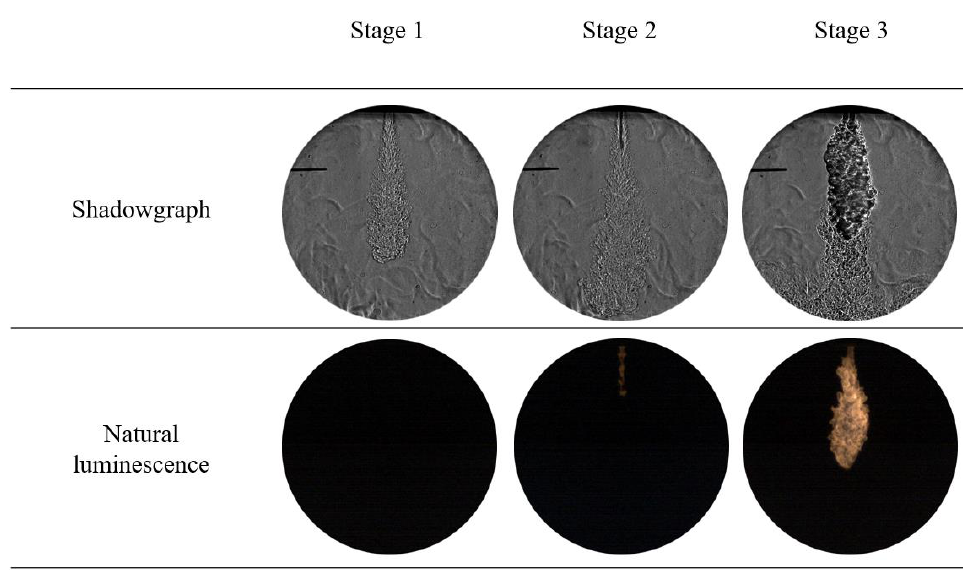
Figure 5. Jet ignition process.